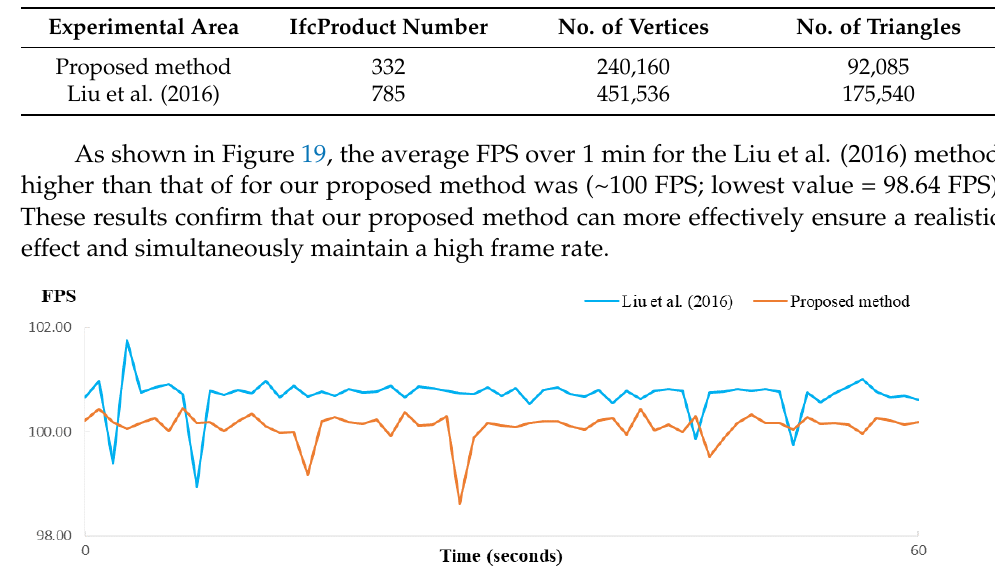
Figure 18. Average frames per second (FPS) for indoor scenes inside the Building Information Model (BIM) model when the outdoors is not visible.